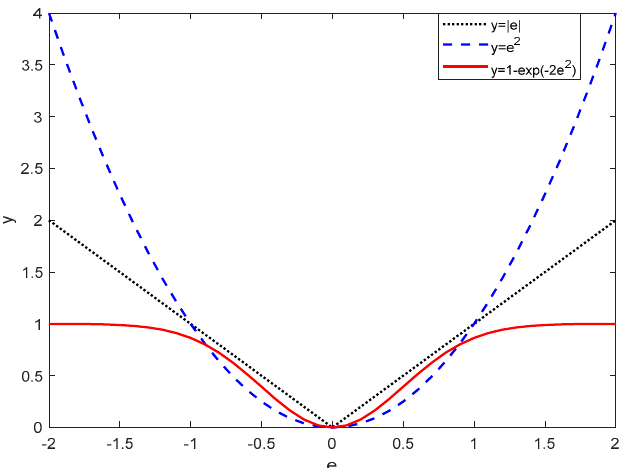
Figure 2. Comparison among the absolute error metric, MSE metric, and CIM.